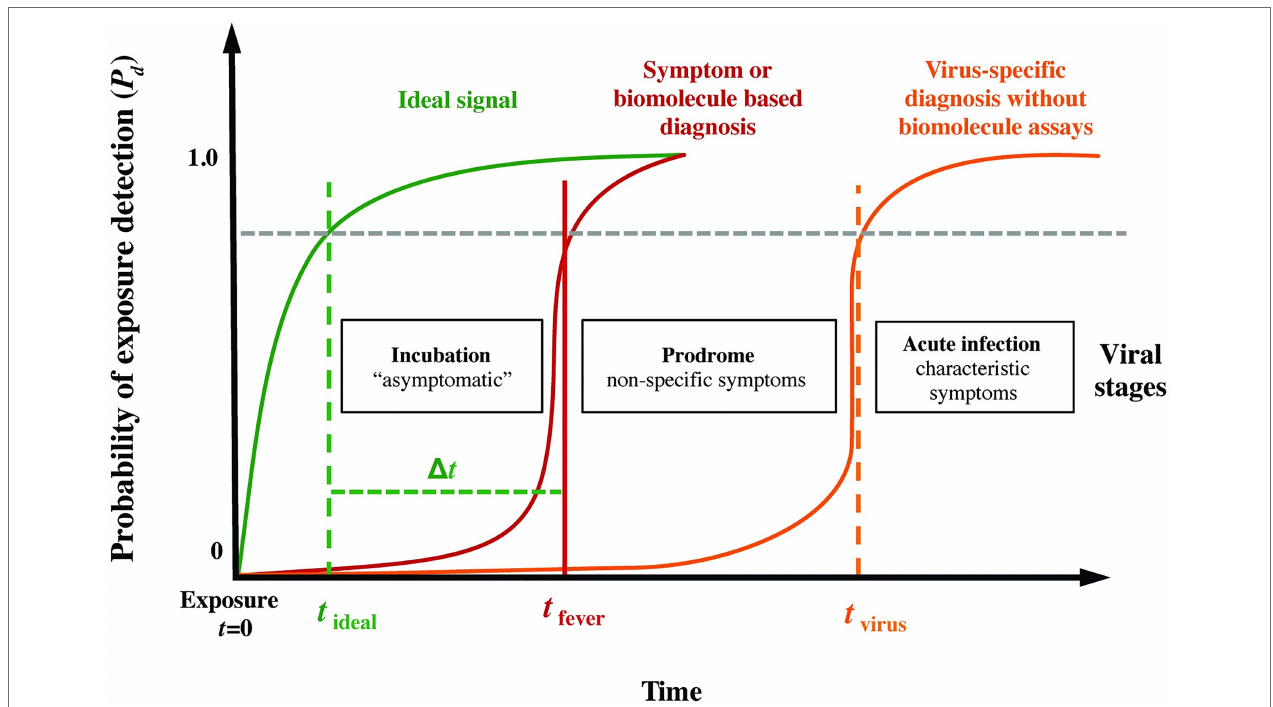
FIGURE 1 | Phases following pathogen exposure. This notional schematic shows the probability of detection ( P d ) for current symptoms-based detection (red curve) and an ideal signal (green curve) vs. time (viral exposure at t = 0), overlaid with a typical evolution of symptoms. An ideal sensor and analysis system would be capable of detecting exposure for a given P d (and probability of false alarm, P fa ) soon after exposure and during the incubation period ( t ideal ), well before the non- specific symptoms of the prodrome ( t fever ). We define the difference Δ t = t fever − t ideal as the early warning time